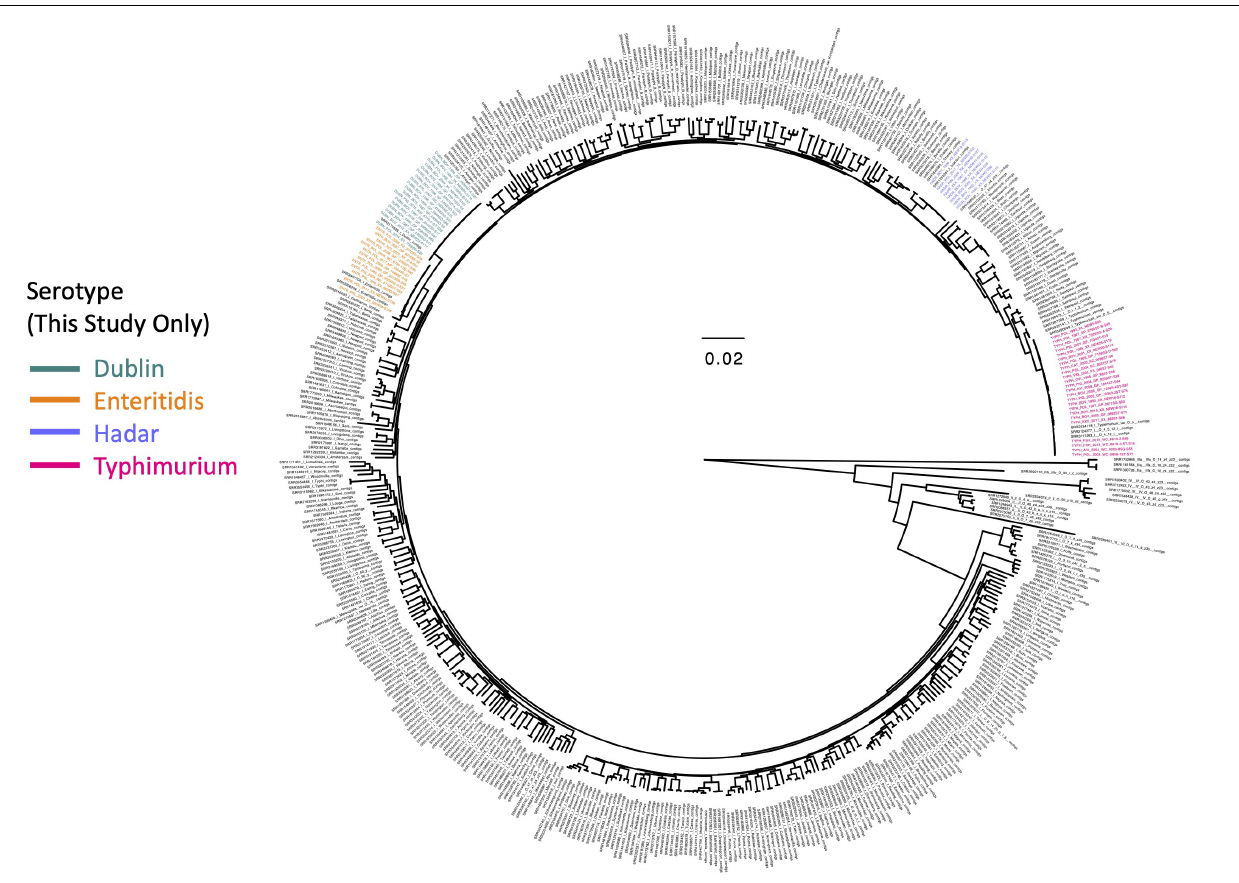
FIGURE 1 | Maximum likelihood phylogeny constructed using core SNPs identified among 505 Salmonella isolate genomes. Publicly available genomes are denoted by black tip labels ( n = 442), while genomes of strains isolated in conjunction with this study are denoted by tip labels colored by serotype ( n = 63). The phylogeny is rooted at the midpoint with branch lengths reported in substitutions per site. Core SNPs were identified among all genomes using kSNP3, while the phylogeny was constructed and annotated using IQ-TREE and FigTree v. 1.4.4,